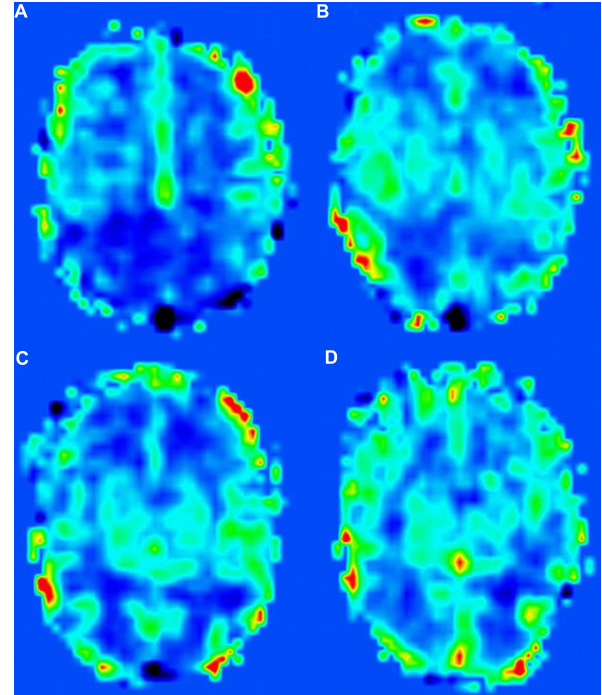
Fig. 2. The CBF images in different slices of a control neonate (7 days old, gestational age of 38 weeks and 4 days, and weight of 4.3 kg). (A– D) CBF images showed different blood perfusion in different areas. The red areas in the cerebral cortex indicate high perfusion. The blue areas in the white matter illustrate low perfusion. The green areas in the basal ganglia region show the perfusion between red and